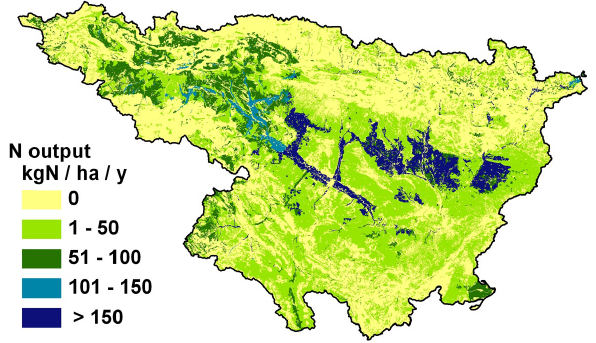
Fig. 2. Spatialized crop N outputs in the Ebro River Basin. Similar maps have been created for all N inputs. Similar maps for the other terms of the N budget are presented in Supplement, S4.